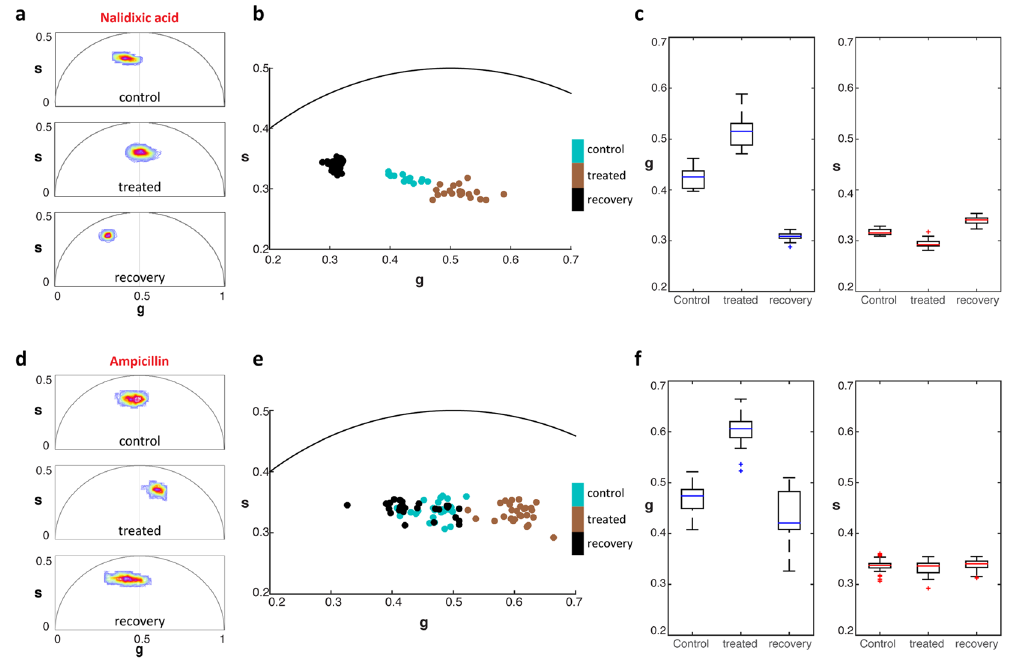
Figure 3. Bacterial phasor response to antibiotic treatment and recovery. ( a ) Phasor distributions of E. coli (control), E. coli treated with 0.464 mg/ml nalidixic acid for 30 min (treated), and treated E. coli recovered in fresh growth medium for 30 min (recovery). ( b ) Individual bacterial cell phasor of control, treated, and recovery groups exposed to nalidixic acid and their corresponding g and s distributions ( c ). ( d ) Phasor distributions of E. coli (control), E. coli treated with 0.4 mg/ml ampicillin for 30 min (treated) and treated E. coli recovered in fresh growth medium for 30 min (recovery). ( e ) Individual bacterial cell phasor of control, treated and recovery groups exposed to ampicillin and their corresponding g and s distributions ( f